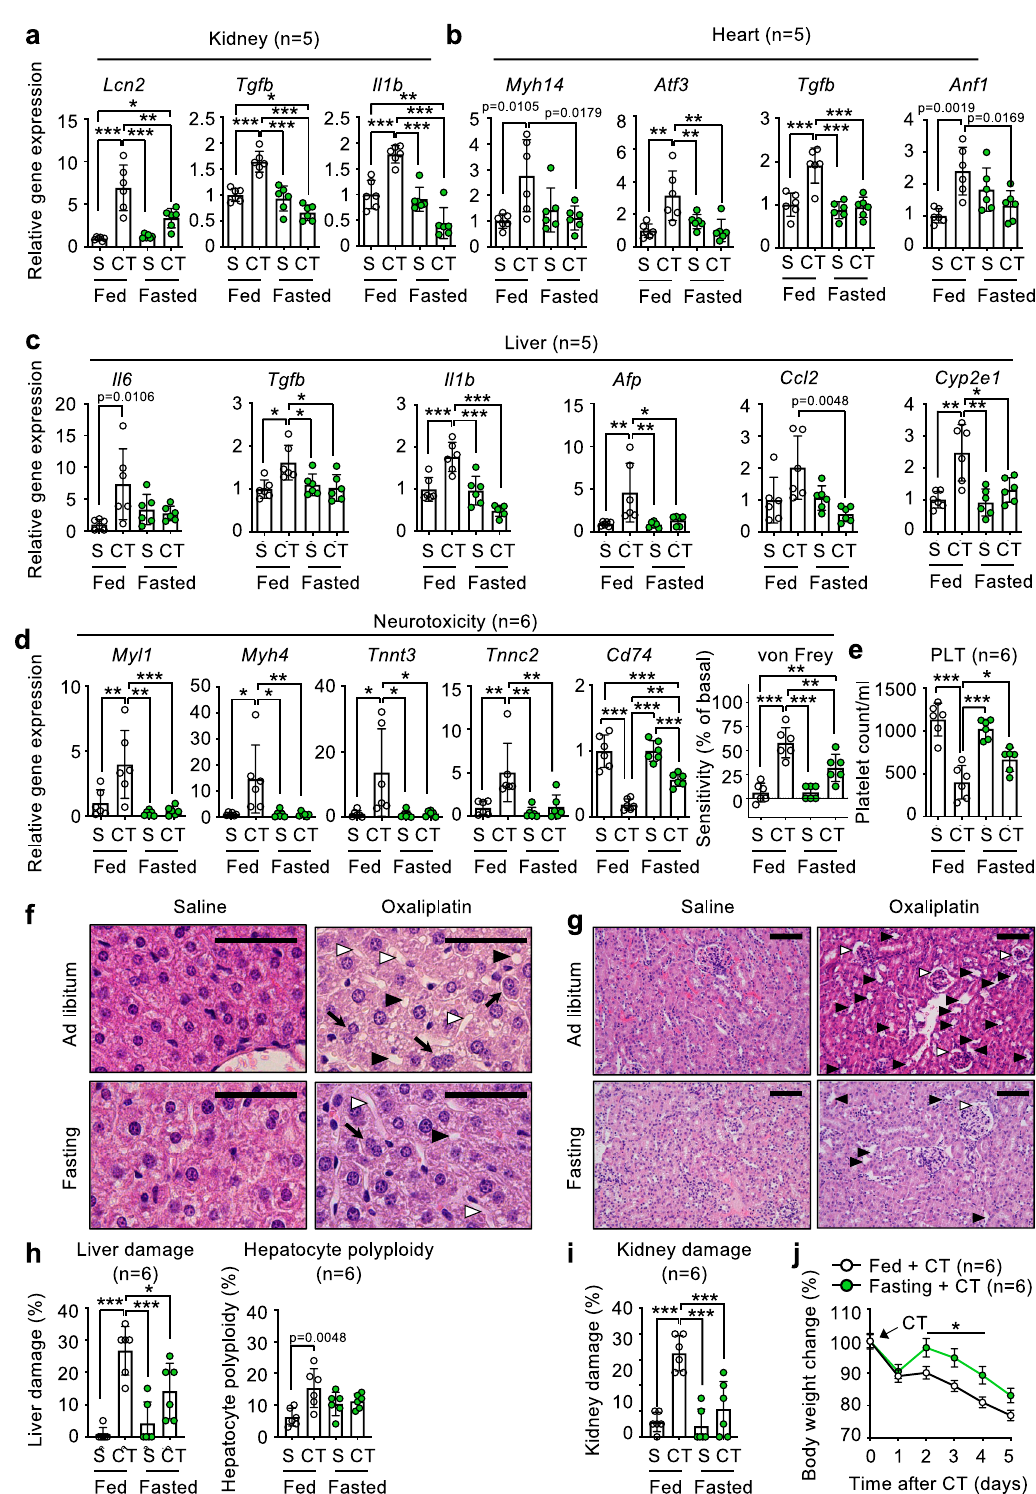
Fig. 5| Fastingprotects fromoxaliplatin-inducedmulti-organtoxicity in mice. a – e Expressionoftheindicatedtoxicity-reportergenesinkidney( a ),heart( b )liver ( c ), and dorsal root ganglia ( d , panels to the left) or the neurotoxicity-measuring vonFreytest( d ,paneltotheright);andbloodplateletscounts( e )frommiceeither fedadlibitumorfastedfor24hbeforeand24hafteri.p.inoculationofsaline(S)or 15mg/kgoxaliplatin(CT),andsacri fi ced5daysafterchemotherapyadministration. f , g Representativephotographsofhematoxilinandeosinstainingofsectionsfrom liver ( f ) or kidney ( g ) from the same mice as in ( a – e ),sizebar=200 μ M. In liver ( f ), black triangles point to lipid vacuoles; white triangles point to sinusoidal dilata- tions; and black arrows point to polyploid hepatocytes. In kidney ( g ), black